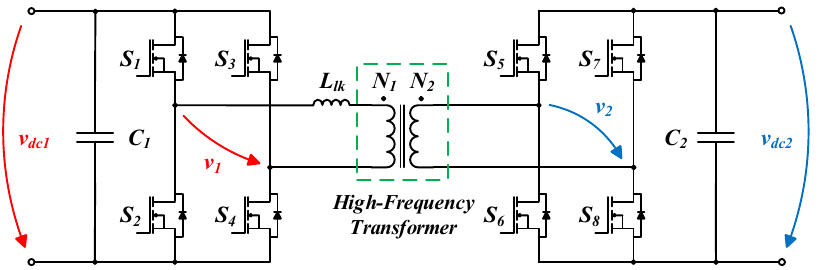
Figure 4. Electrical schematic of the isolated bidirectional DAB converter, interfacing the dc grid.